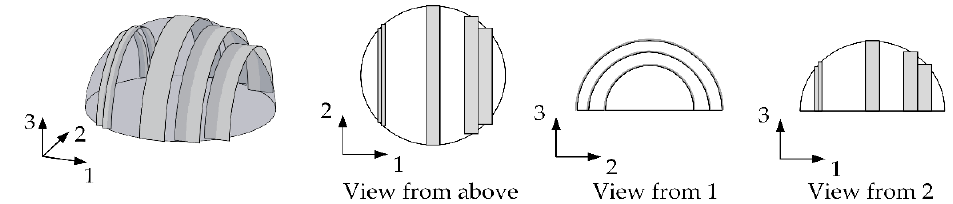
Figure 5. Path length di ff erences between the edges of tows on the surface of a hemisphere / a double curved surface; adapted from [1].